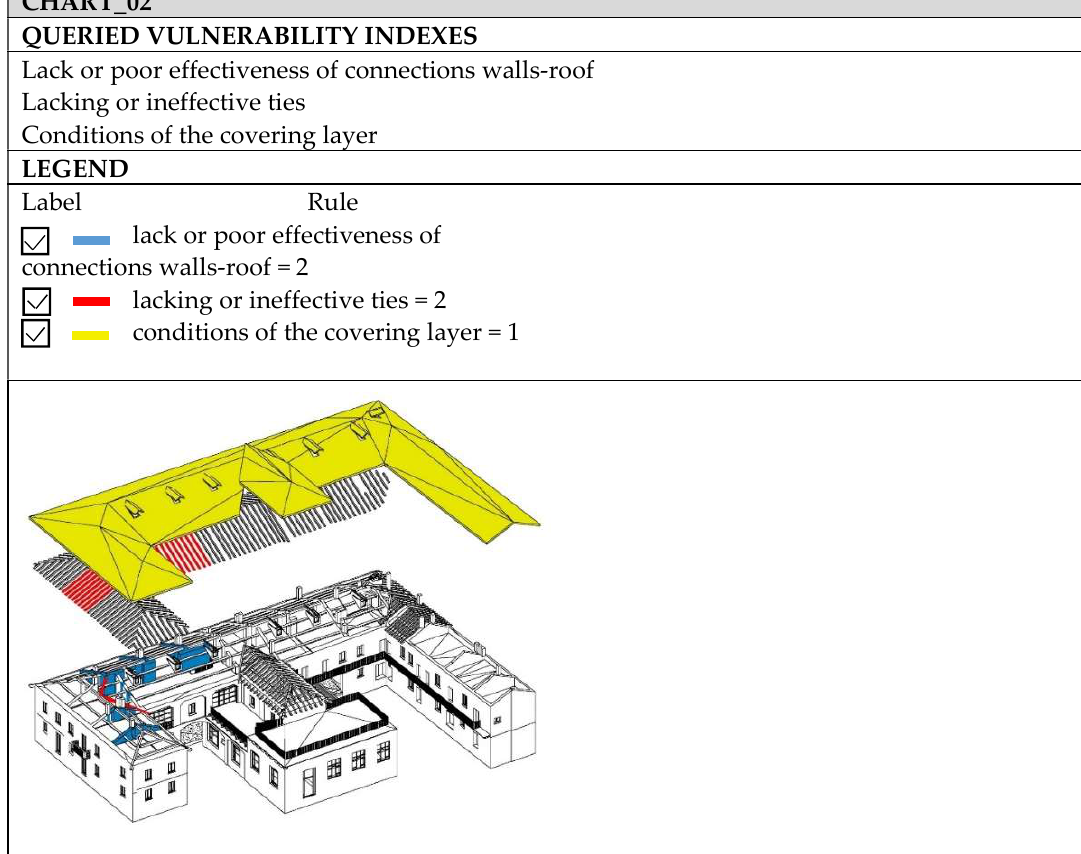
Figure 11. Integrated queries: display of three di ff erent types of specific vulnerabilities with an impact of less than 2 on the overall